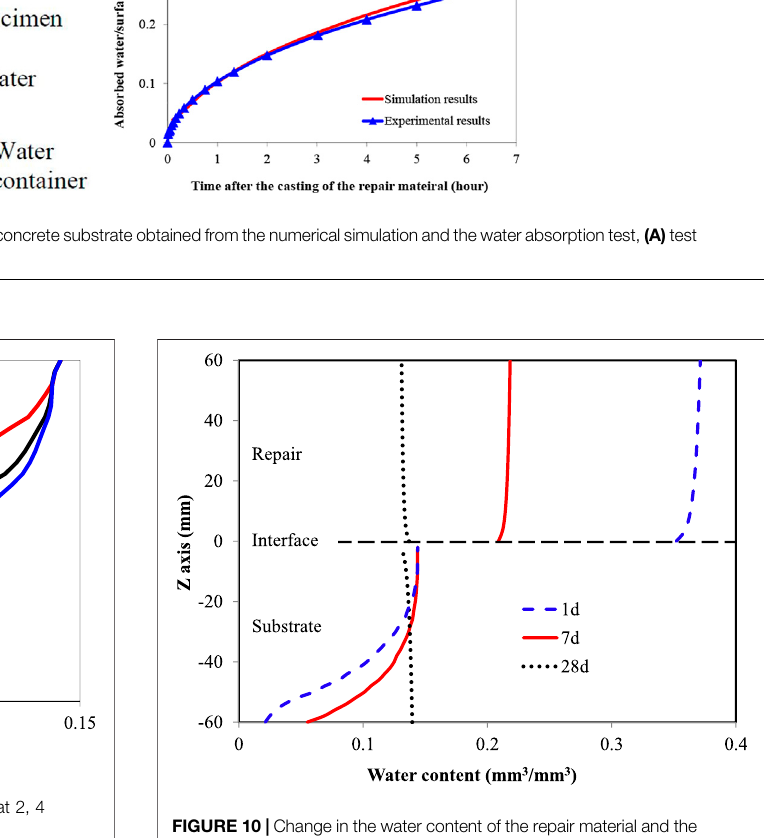
concrete substrate at 1, 7, and 28 days obtained from the numerical